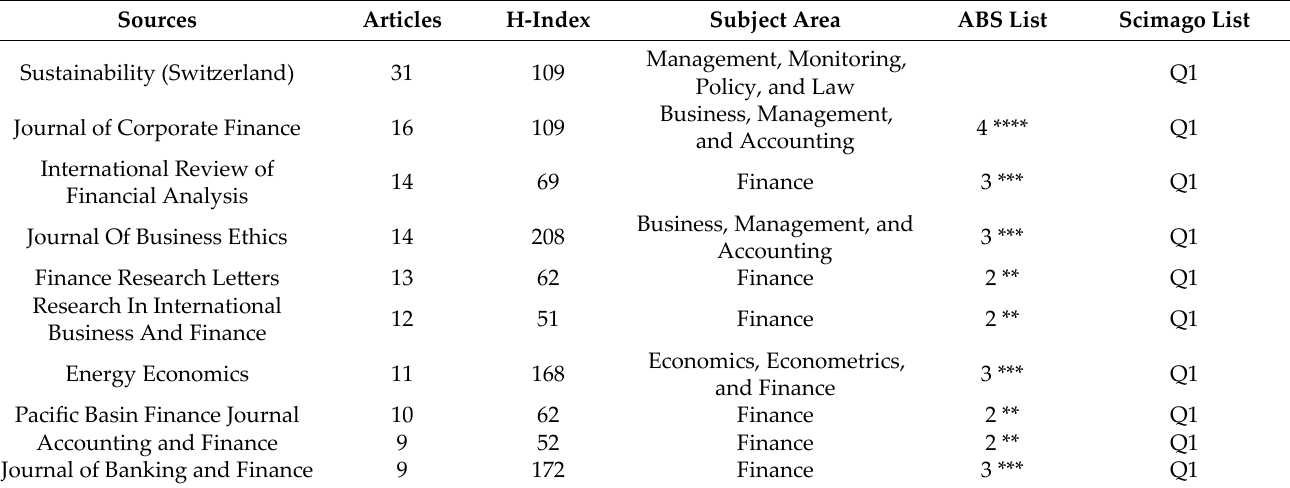
Table 2. Top 10 relevant sources based on several publications. Source: Scopus/Biblioshiny (Own